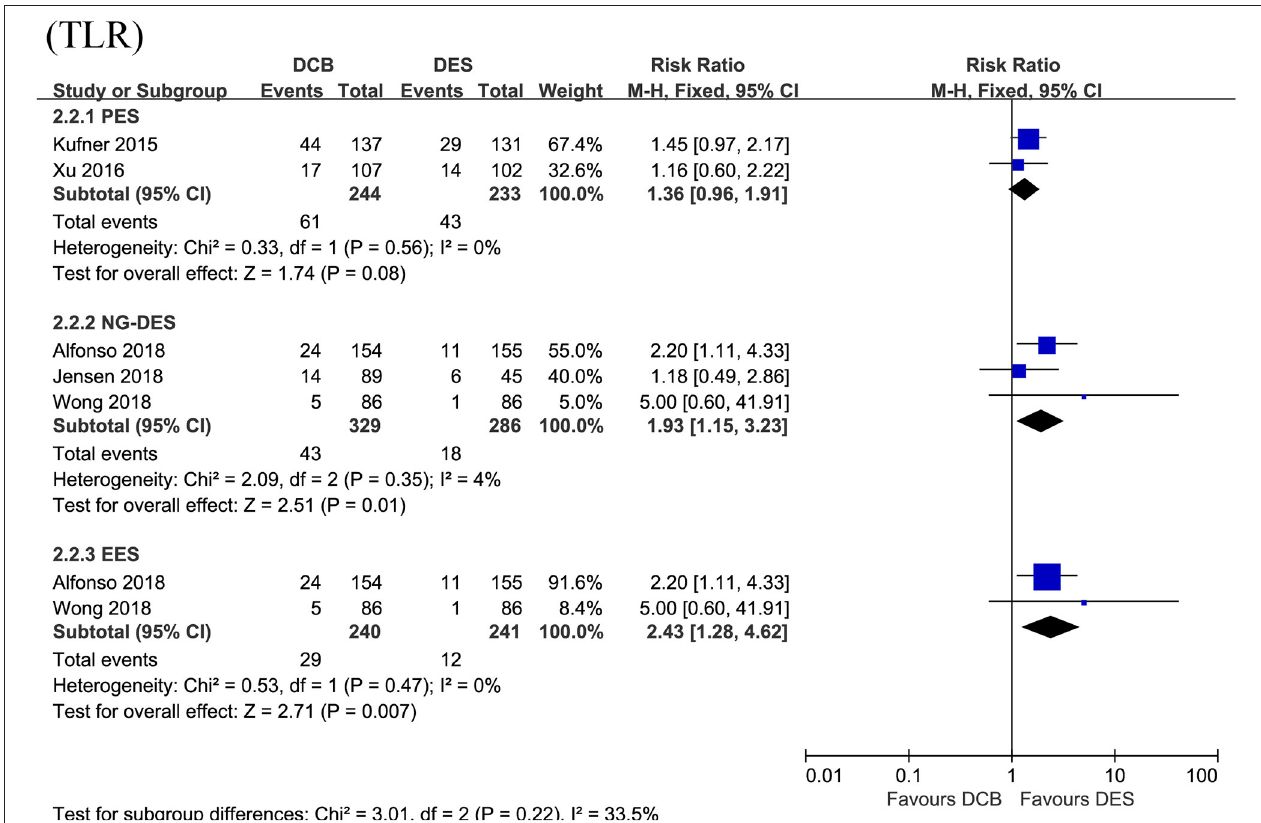
FIGURE 4 | Subgroup analysis for the primary endpoint TLR according to the type of DES used. TLR, target lesion revascularization; DES, drug-eluting stents; PES, paclitaxel-eluting stents; NG-DES, new-generation DES; EES, everolimus-eluting